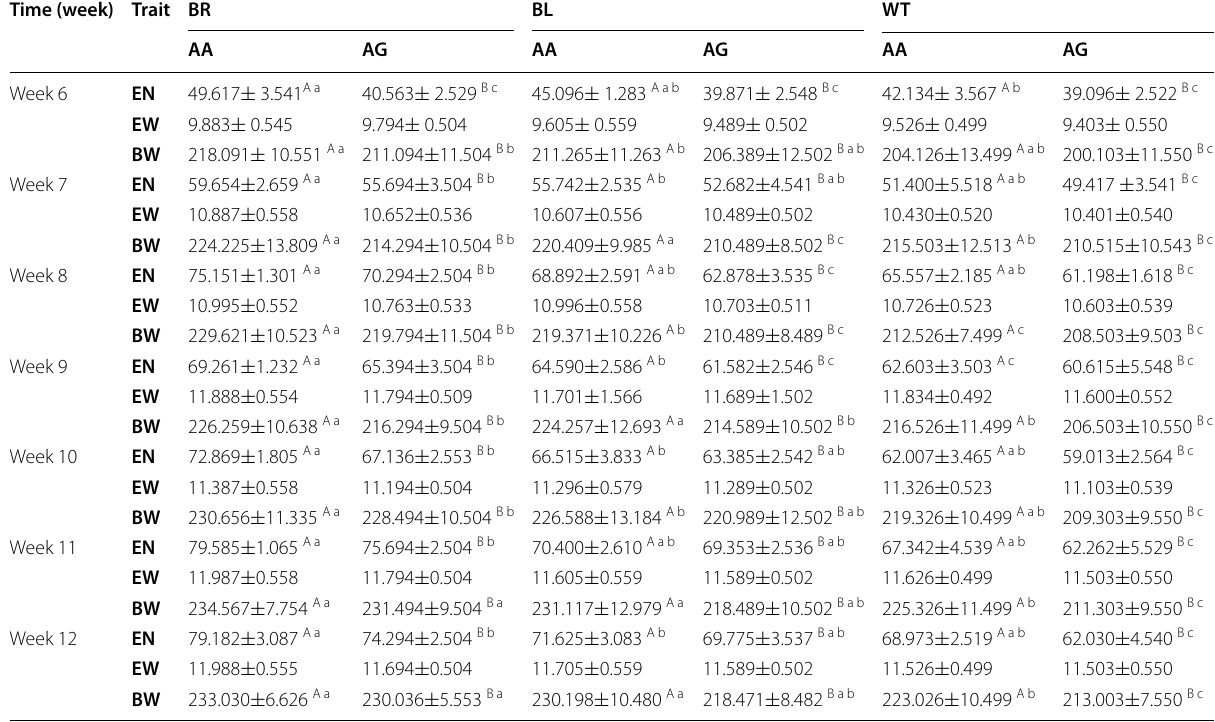
SE) of interaction effects of AA and AG genotypes on egg production traits in three lines of Japanese